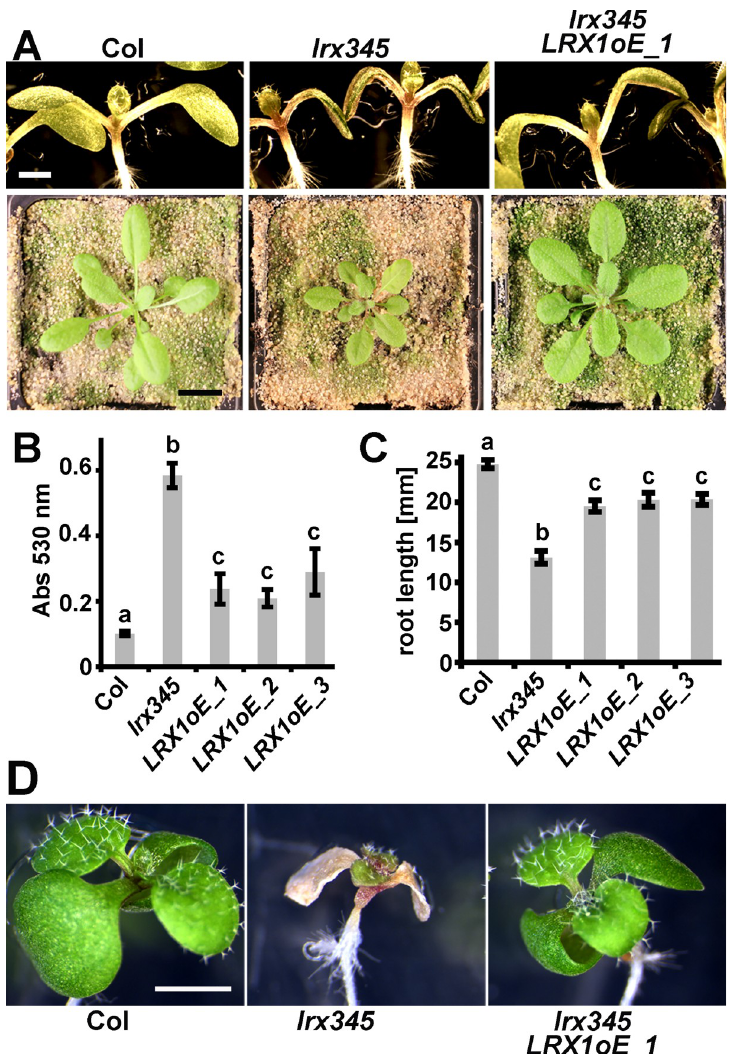
Fig 5. Functional redundancy among LRX proteins. (A-C) Complementation of the lrx345 triple mutant with the 35S : LRX1 ( LRX1oE ) construct. Representative examples are shown. (A) Seedling shoots after 7 days of growth on half- strength MS (upper lane) and plants grown in soil (lower lane). (B) Anthocyanin accumulation in 12-days-old seedlings is increased in the lrx345 . (C and D) The lrx345 mutant seedlings grown in the presence of 100 mM NaCl show increased salt sensitivity, resulting in shorter roots (C) and impairment of shoot growth (D) compared to control Col. These phenotypes are alleviated by LRX1 overexpression. Error bars represent SEM; different letters above the graphs indicate significant differences (T-test, N > 20, P < 0.05). Bars = 3 mm (A top); 1 cm (A bottom), 2 mm (D). from the start codon to the CRD (Fig 1A) and the extensin coding sequence, respectively). The constructs encoding the chimeric proteins were placed under the control of the 35S promoter and were transformed into the lrx1 and lrx1 lrx2 mutants. For each of the three constructs, sev- eral independent T lines were identified, all of which showed expression of the transgene at 2 the transcriptional level (S6B Fig). The root hair growth defect of the lrx1 mutant (S7B Fig) as well as the stronger lrx1 lrx2 double mutant phenotype (Fig 6A) were suppressed by all of the three chimeric constructs.